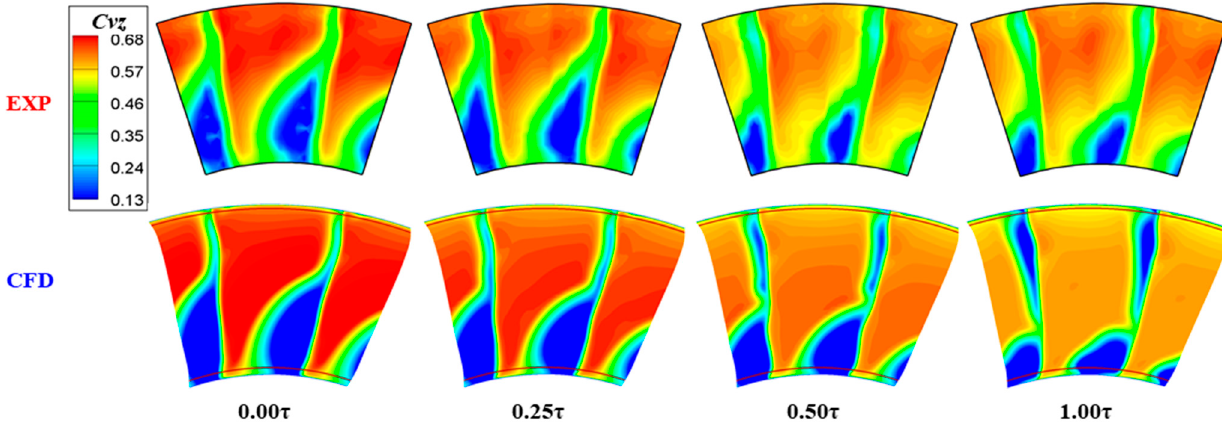
Figure 7. Distribution of the normalized axial velocity of the stator outlet in the DE condition.